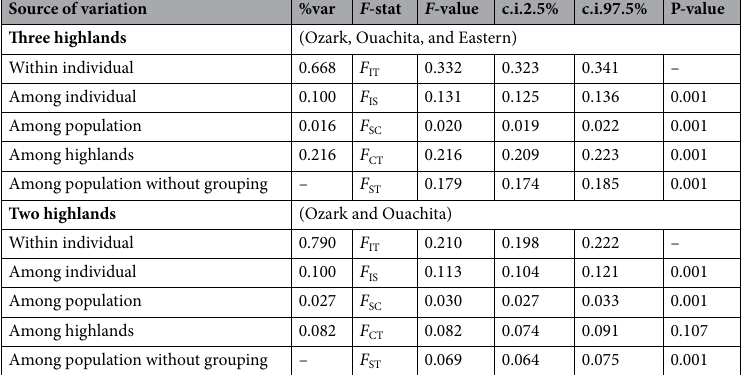
Table 3. Summary of hierarchical AMOVA analysis for Cyprogenia from the highland regions based on 7243 SNP loci. A total of 146 individuals except two geographically isolated individuals (Ozark_105 and Ozark_107) were included in this analysis. AMOVA was conducted separately according to hierarchical groupings. Three Highlands correspond to the Ozark, Ouachita, and Eastern highland regions, consisting of two Cyprogenia species. Two Highlands correspond to Ozark and Ouachita Highlands, regions consisting of same species, C. aberti . Missing data are replaced with randomly drawn alleles based on the overall allele frequencies. Significance was tested using 999